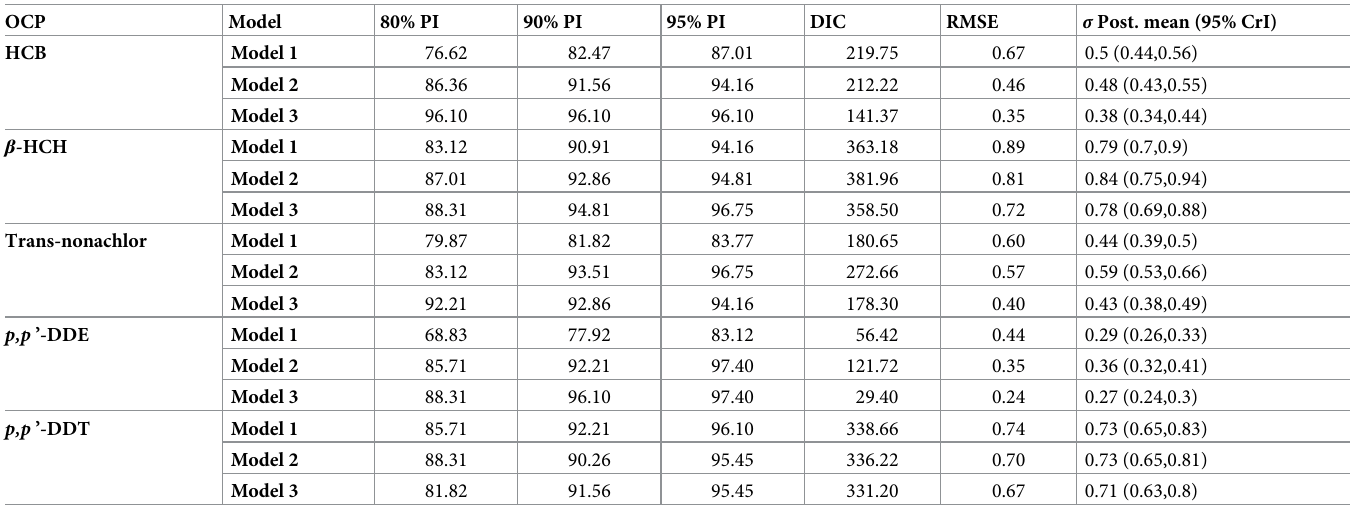
Table 3. Summary of model diagnostics of the three hierarchical models, for HCB, β -HCH, Trans-nonachlor, p,p’ -DDE and p,p’ -DDT by 80%, 90% and 95% predic- tive intervals (PI), deviance information criteria (DIC), root mean squared error (RMSE) and standard deviation ( σ ) of the posterior mean (Post. mean) with a 95% credible interval. Percentages closer to their respective PIs and lower DIC, RMSE and σ values indicate model adequacy.